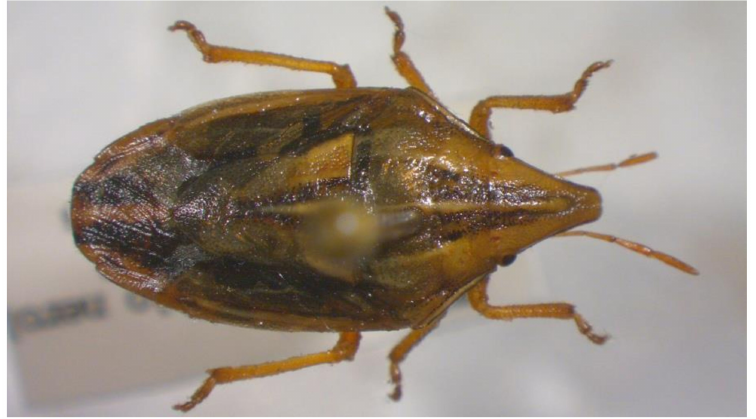
Figure 5. Aelia germari (Collector S. Drosopoulos, Metaxades, 2.VI.1982, posited in S. Drosopoulos historical collection. Photo A. Tsagkarakis,